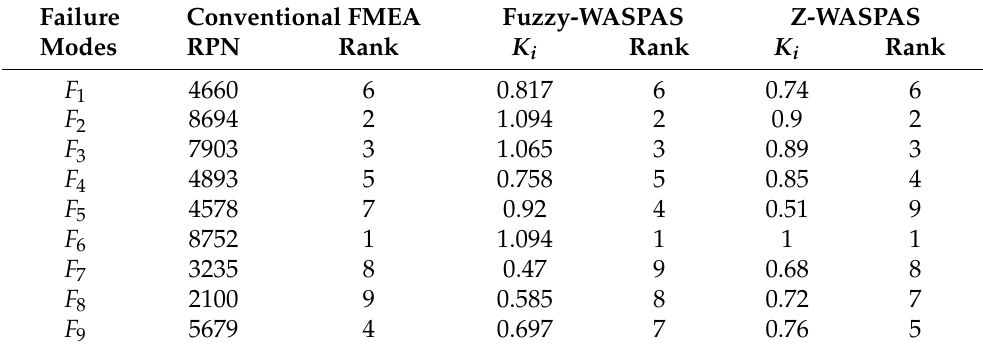
Table 19. Compared to existing strategies, the suggested methodology prioritizes failure